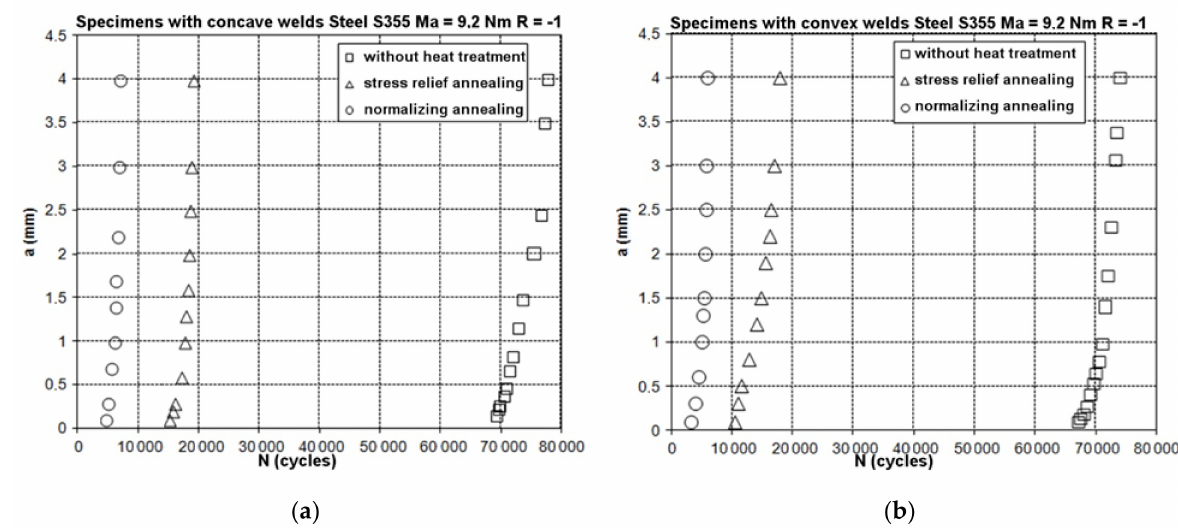
Figure 10. Fatigue crack length vs. number of cycles under bending for specimens with: ( a ) concave welds, ( b ) convex